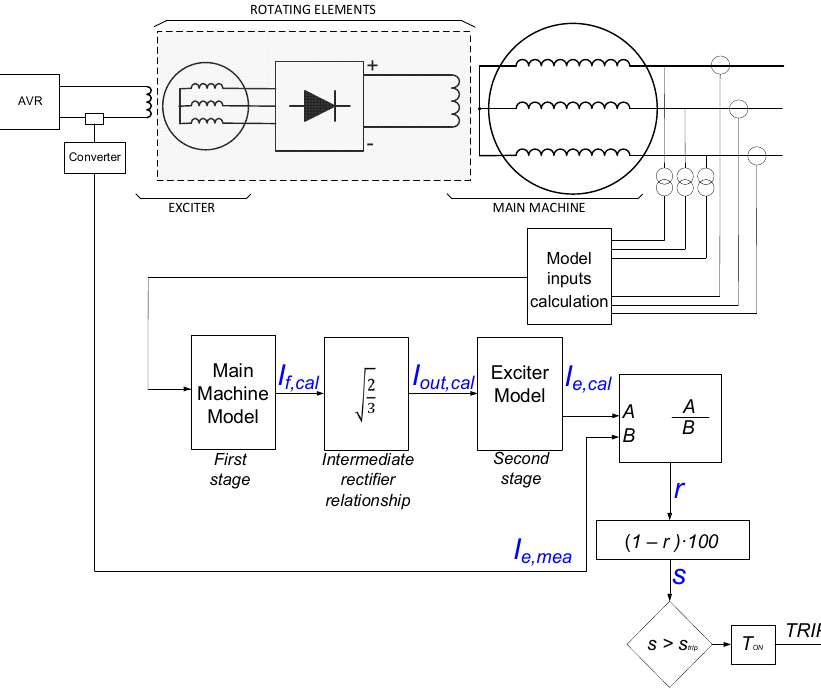
Figure 5. Simplified layout of the detection method for faults in the excitation system of BSM.